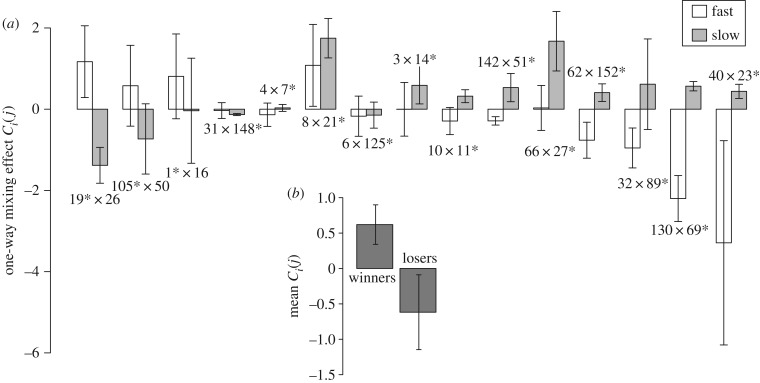
Evolved strains exhibit facultative social exploitation and antagonisms toward one another upon interaction during development. (a) Positive and negative Ci(j) values signify increased or decreased absolute sporulation efficiency as a result of interacting with a competitor, respectively. Competition pairs are shown in the same order as in figure 2 with asterisks indicating strains with a positive Wij estimate for each competition. (b) Average Ci(j) values of winning (Wij> 0) and losing (Wij < 0) competitors across all 15 competition pairings. Error bars represent 95% confidence intervals.